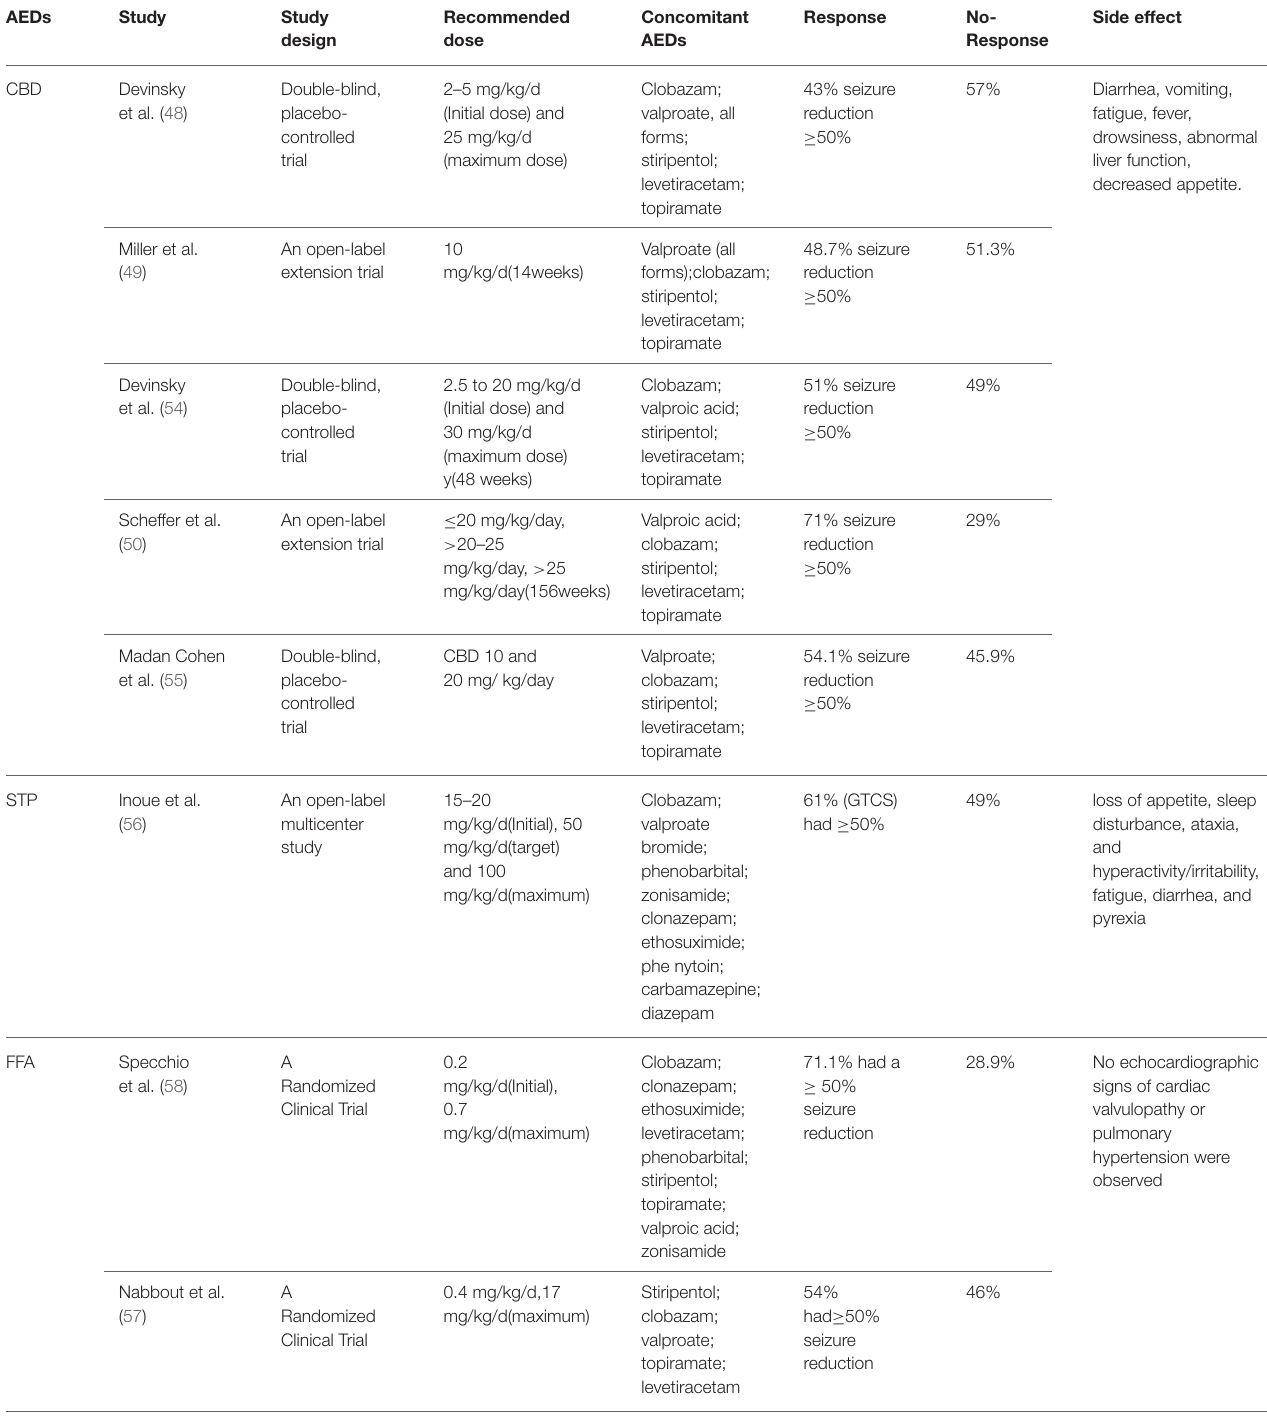
TABLE 3 | Representative studies of novel ASMs for